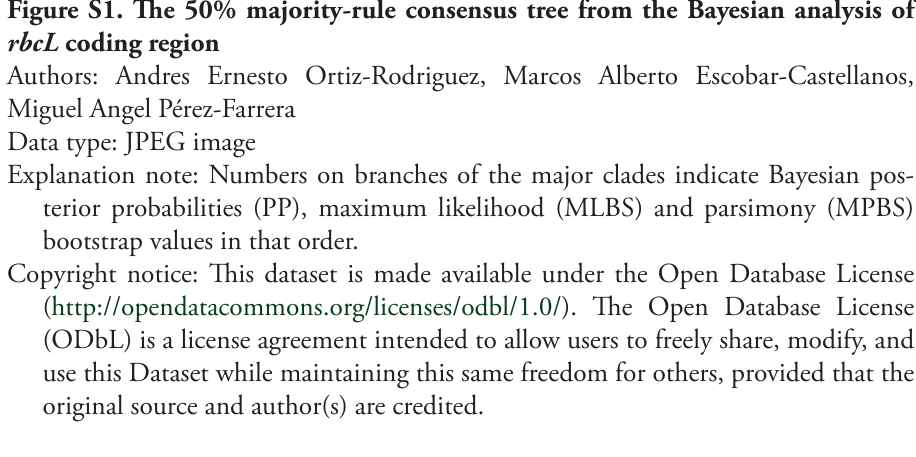
Figure S1. The 50% majority-rule consensus tree from the Bayesian analysis of rbcL coding region